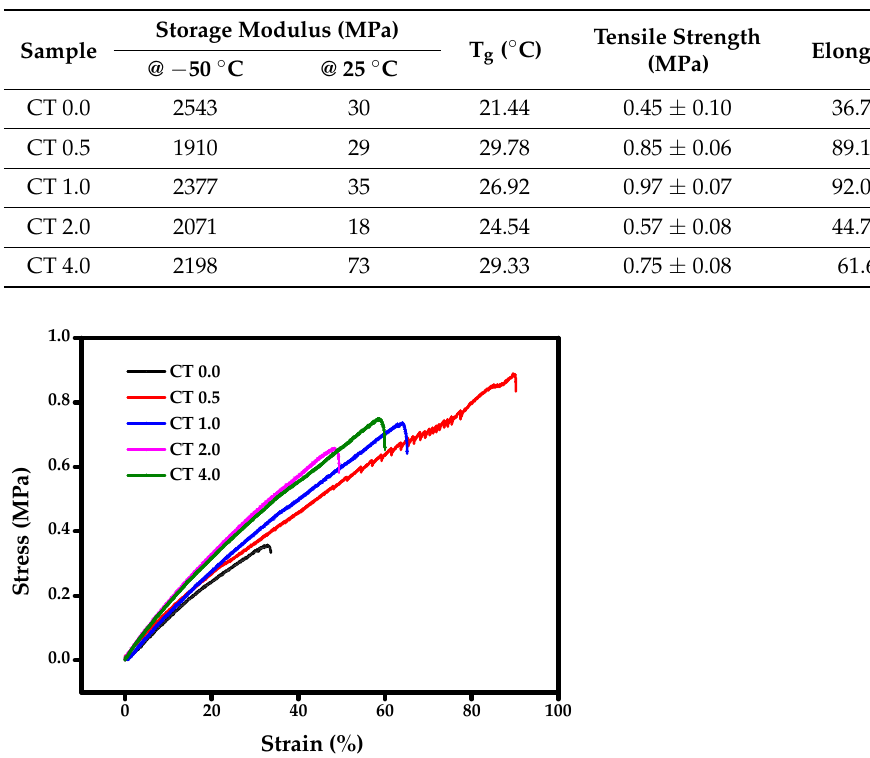
Figure 8. ( A ) Storage Modulus vs. Temperature and ( B ) Tan δ vs. Temperature Curves. Table 4. Dynamic Mechanical and Static Mechanical Properties of the Composite Films.